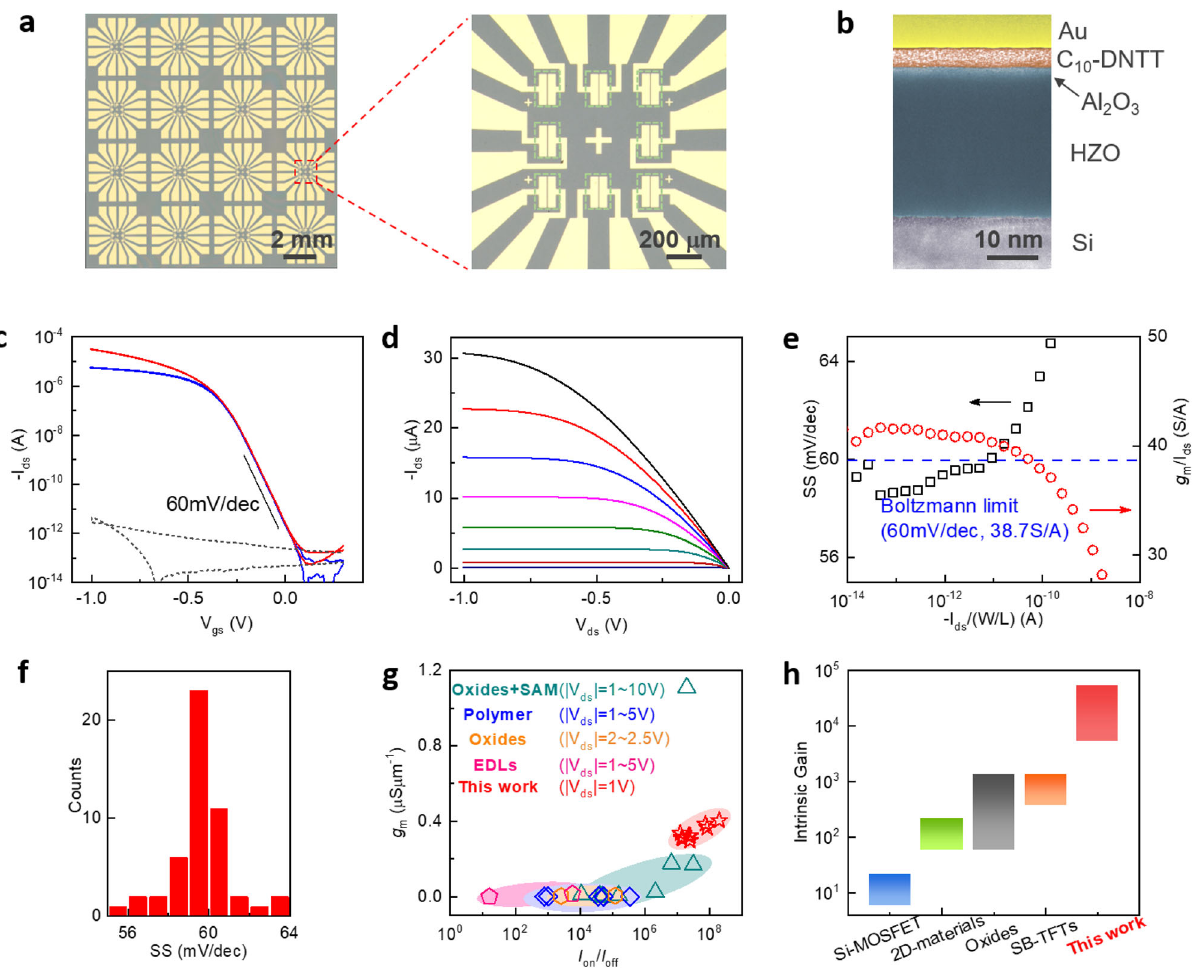
Fig. 2 Transistor characteristics of sub-thermionic monolayer OTFTs. a Photographs of device arrays fabricated on silicon substrate. The length to width ratio ( L / W ) of device channel is 5 μ m/180 μ m. b False-color cross-section TEM image of a device contact region, clearly showing the Au/C 10 -DNTT/ Al 2 O 3 /HZO/Si stack. c Double-sweep I ds − V gs curves of the sub-thermionic OTFT at V ds = − 0.1 V (blue) and − 1 V (red). No hysteresis is observed. The black-dashed line is the gate leakage current. d I ds − V ds curves of the sub-thermionic OTFT. From bottom to top, V gs is from − 0.3 to − 1 V. e SS (black) and transconductance ef fi ciency (red) as a function of I ds for the device in c . The Boltzmann limit reference corresponds to 300 K under which our measurements were taken. f Statistical distributions of one-decade SS for 50 devices. g Comparison of I on / I off and normalized transconductance at | V gs(on) − V = 1 V among OTFT technologies using different dielectrics. The extracted data are listed in Supplementary Table 2. h Comparison of intrinsic gs(off) | gain among different TFT